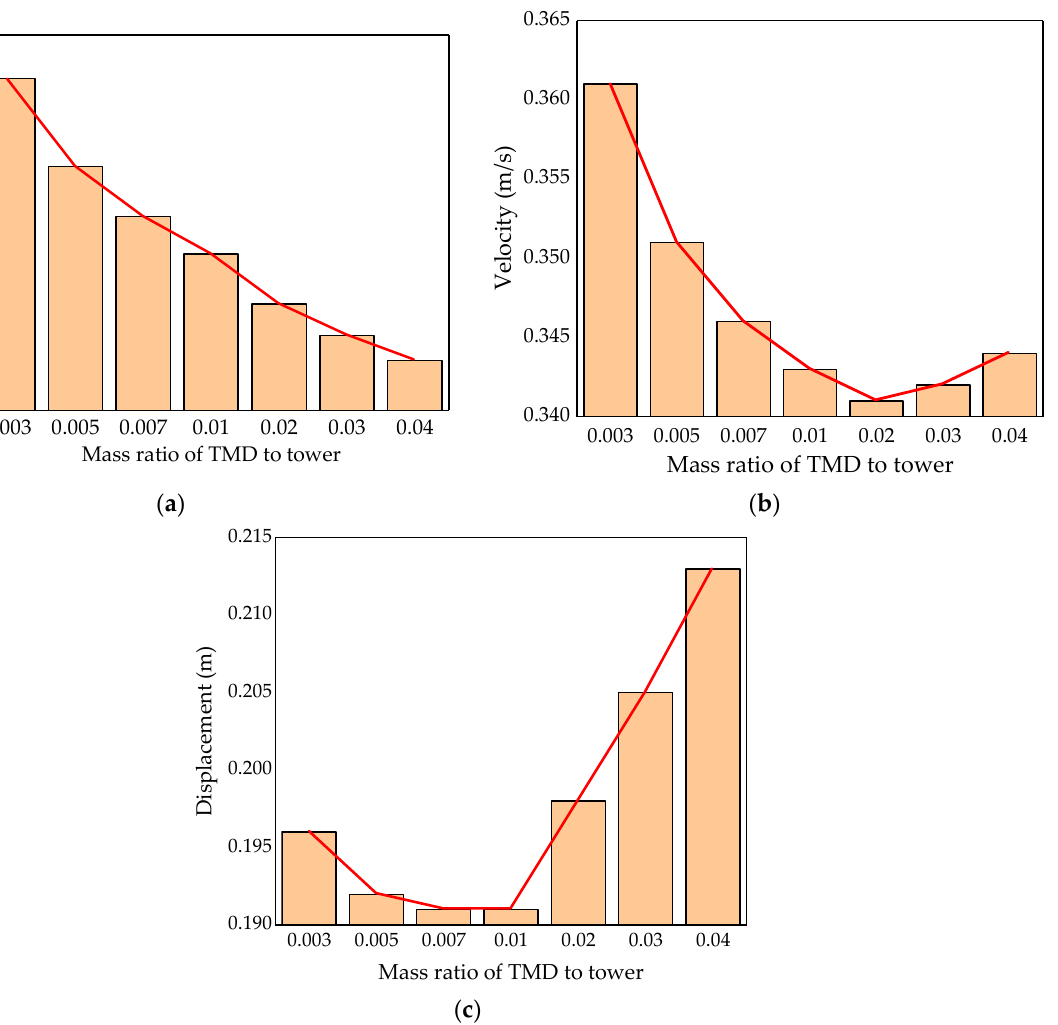
Figure 12. Dynamic response of tower top with different TMD mass ratios: ( a ) acceleration; ( b ) velocity; ( c ) displacement.